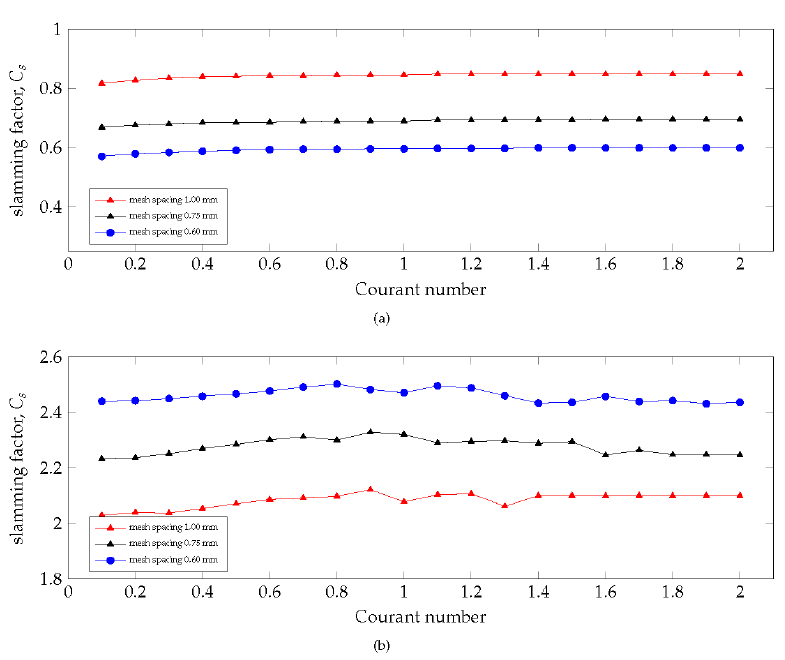
Figure 11. Results of the time step size ∆ t study: ( a ) Results for F stat ; ( b ) Results for F max